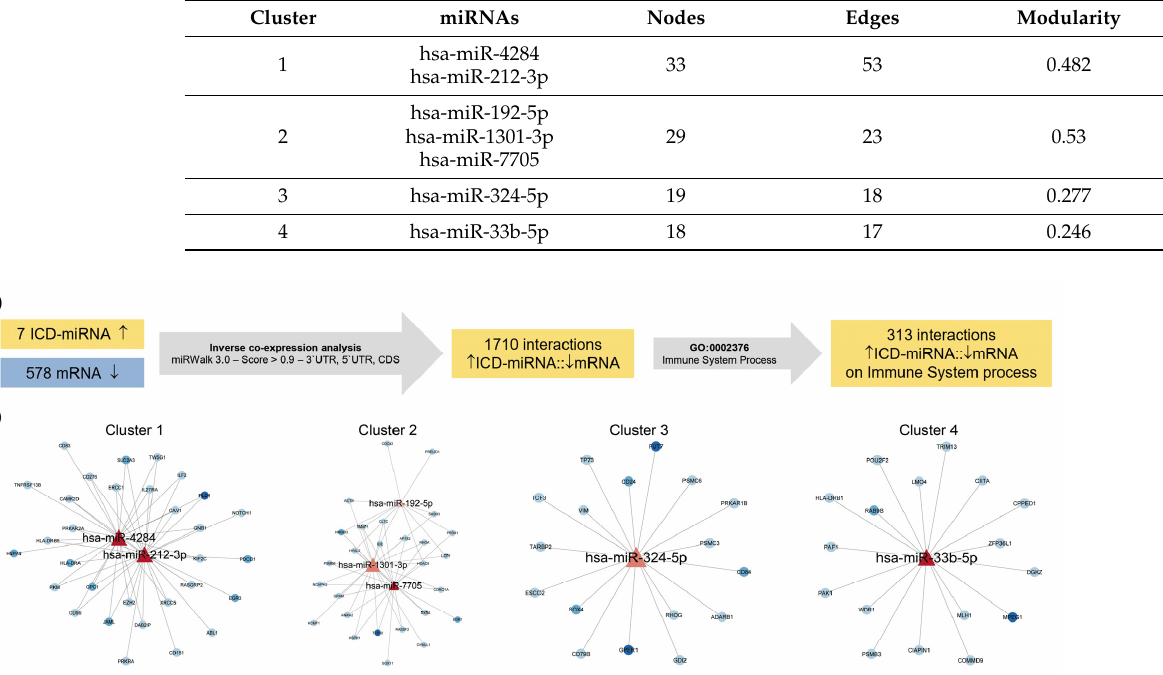
Table 3. Cluster generation of upregulated ICD-miRNA: mRNA pairs. Nodes: Vertices of the network (here, miRNAs and genes). Edges: Connections between the nodes interactions within the network (here, miRNA:mRNA interaction). Modularity: Comparison between the observed and expected number of edges between nodes in the same cluster.